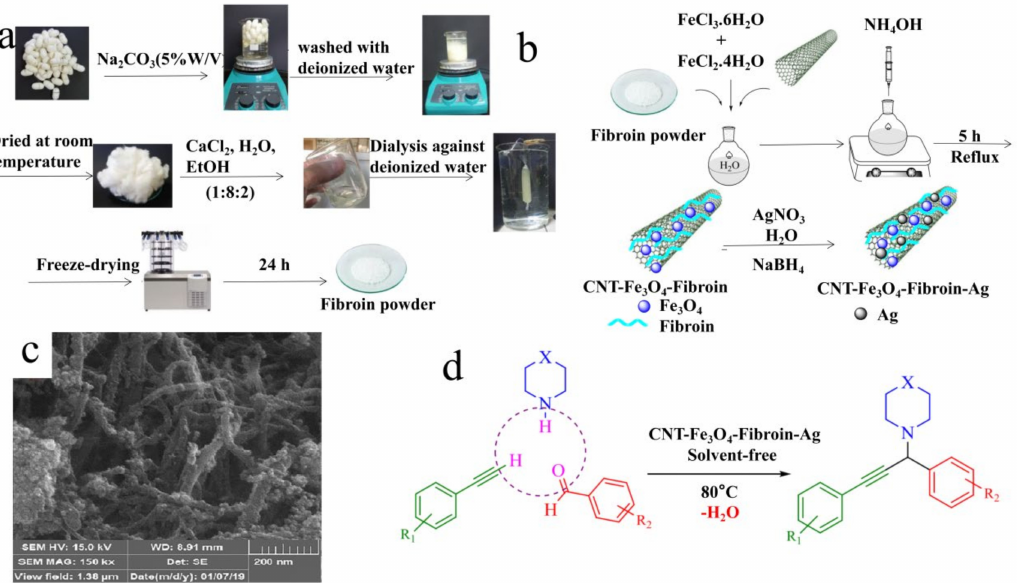
Figure 4. ( a ) Preparation procedure of fibroin powder, ( b ) process for the preparation of CNT–Fe 3 O 4 – fibroin–Ag, ( c ) scanning electron microscopy images of CNT–Fe 3 O 4 –fibroin, ( d ) A3 coupling